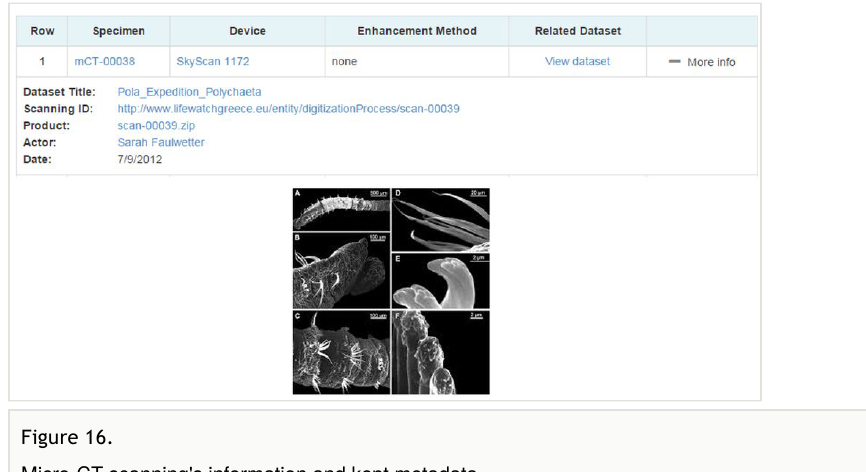
Figure 16. Micro-CT scanning's information and kept